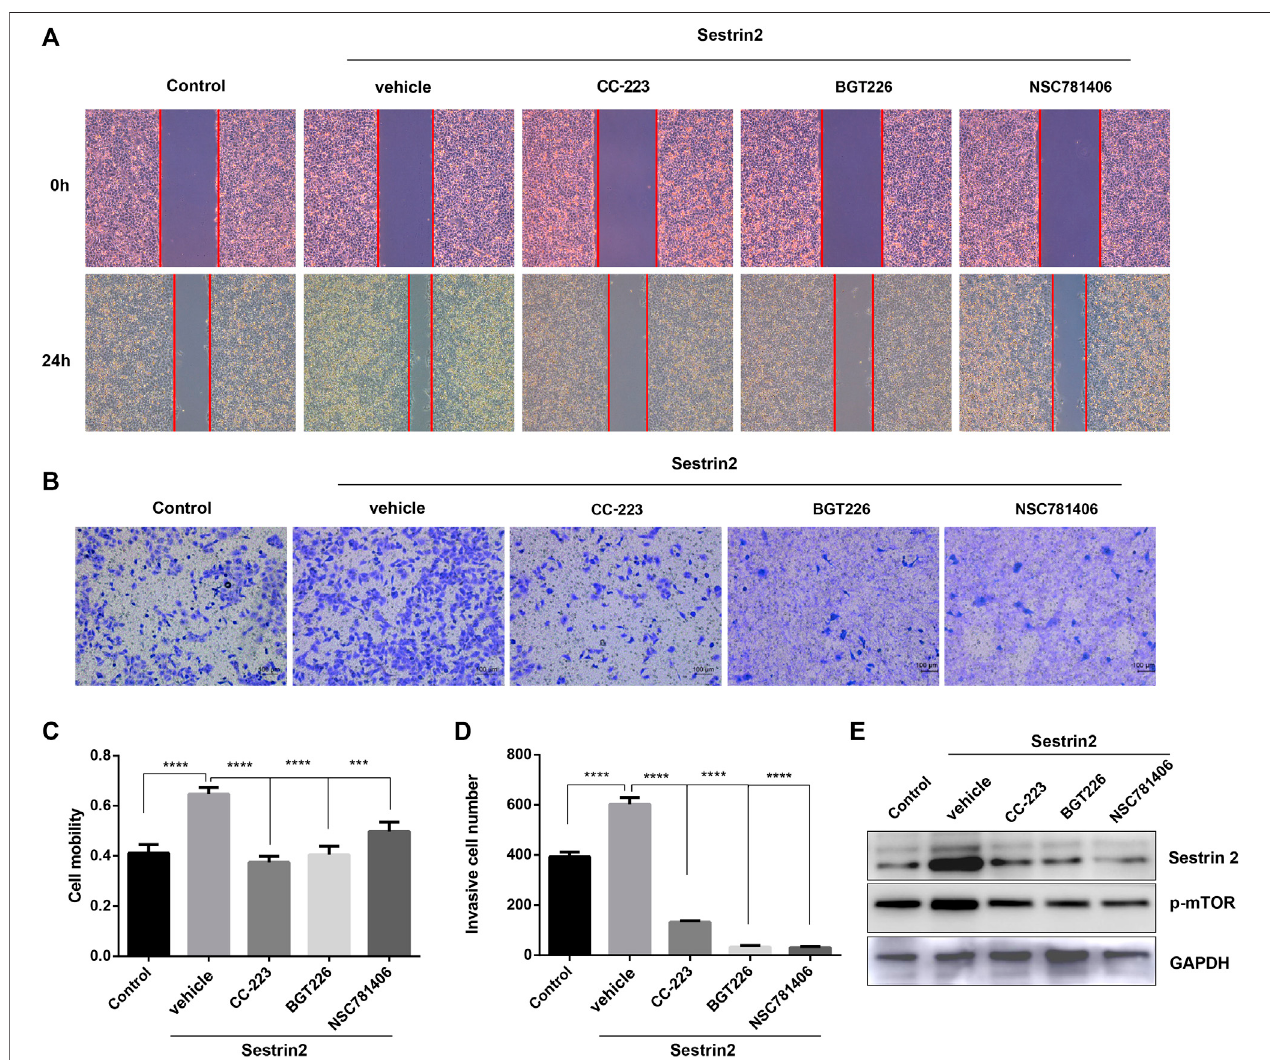
FIGURE 7 | mTOR inhibitors reversed the effect of Sestrin2 overexpression on the biological behavior of pancreatic cancer. (A,C) Wound healing assay. PANC-1 cellswithSestrin2overexpressionornotweretreatedwith20 μ MCC-223,NSC781406,andBGT226andincubatedfor24 h. (B,D) Transwellassay.PANC-1cellswith Sestrin2overexpression ornotweretreatedwith20 μ MCC-223, NSC781406,and BGT226 andincubated for24 h. (E) WesternblotanalysisofSestrin2and p-mTOR. *** p < 0.001; **** p < 0.0001.